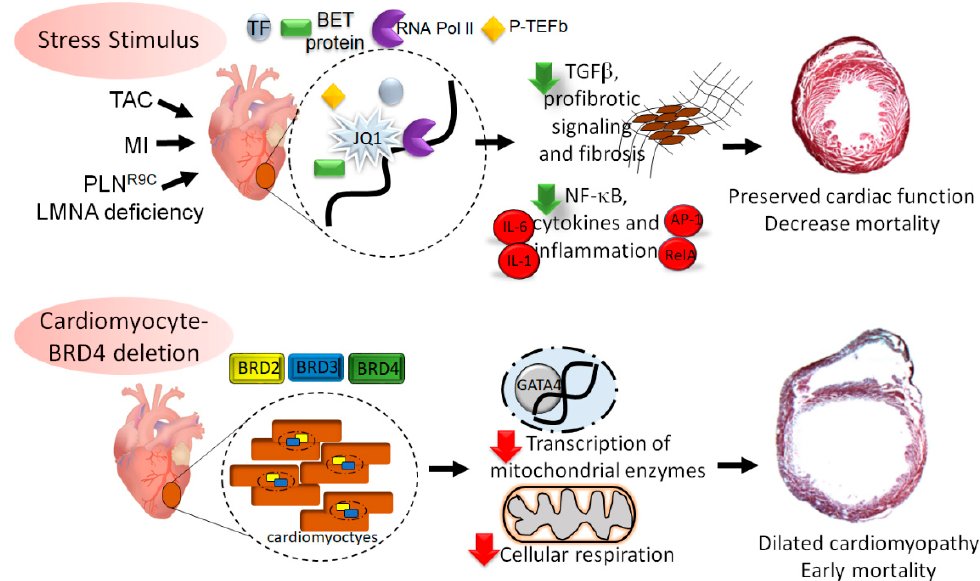
Figure 3. BRD4 is essential for cardiomyocyte homeostasis. Multiple forms of cardiac stress, including transverse aortic constriction (TAC), myocardial infarction (MI), and genetic defects PLN R9C or LMNA deficiency could be blunted by BD inhibitor JQ1. Recent evidence also suggests that BET protein BRD4 is involved in maintaining mitochondrial homeostasis in cardiomyocyte via a BD-independent mechanism and complete deletion leads to DCM and HF.